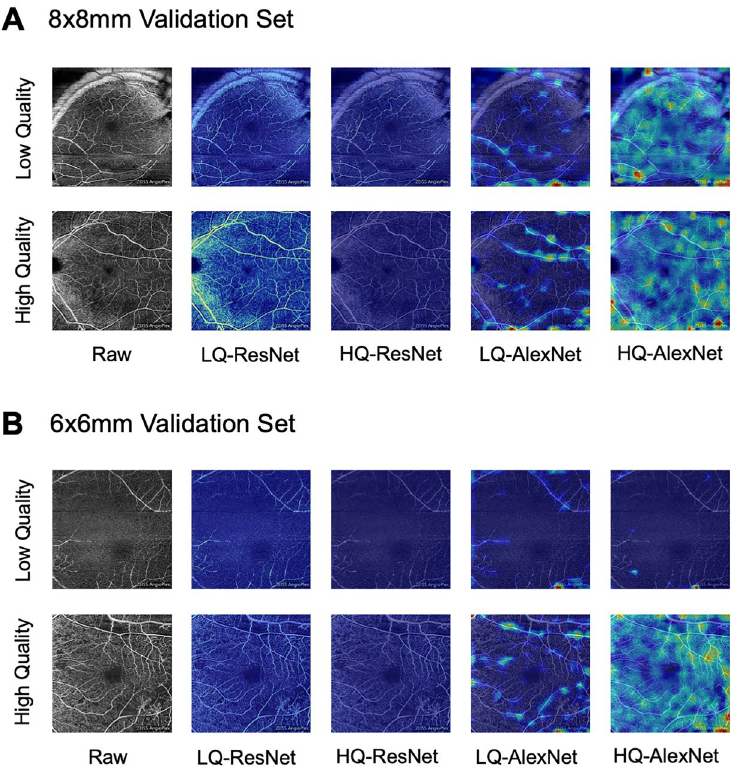
Figure 4. Class activation maps for ResNet152 and AlexNet models highlight features associated with image quality. ( A ) Class activation maps show coherent activation following the superficial retinal vasculature in the 8 × 8 mm validation images and ( B ) to a lesser degree in 6 × 6 mm validation images. LQ model trained with low- quality criteria, HQ model trained with high-quality